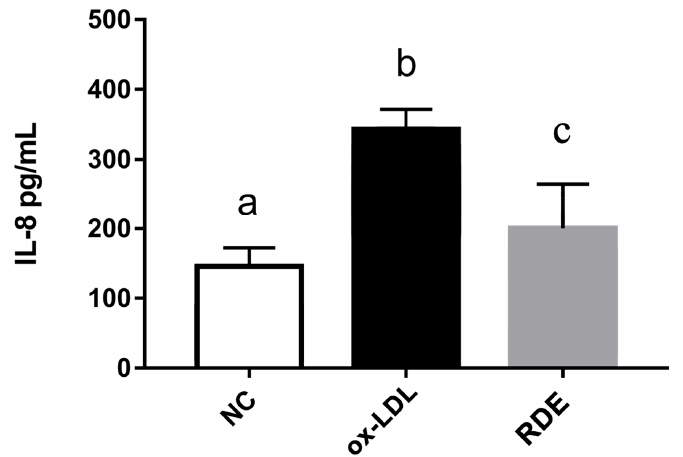
Figure 9. IL-8 production by EA.hy926 cells in the Caco-2 BBe1/ EA.hy926 co-culture model in response to no treatment (NC), ox-LDL induced inflammation (ox-LDL), or RDE treatment with a following ox-LDL induced inflammation (RDE). Caco-2 BBe1 cells on the apical compartment were supplemented with 100 μ g/mL RDE for 1 h, followed by an incubation of 100 μ g/mL ox-LDL on the EA.hy926 cells for 6 h. Values are presented as means ± SEM, n = 4. Shared letters indicate no significant difference ( p > 0.05).